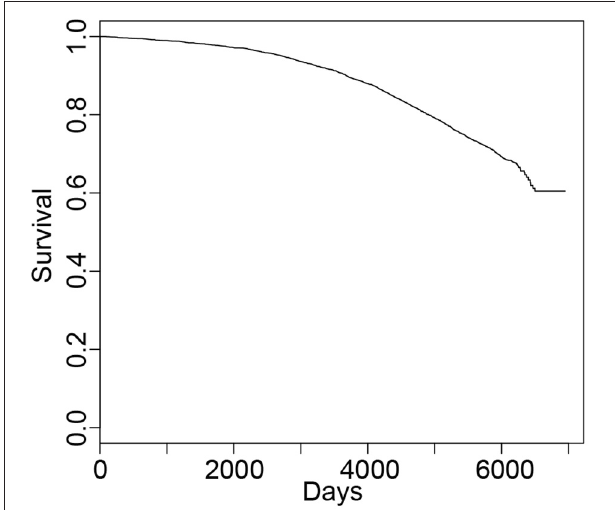
FIGURE 1 | Survival curve for all-cause mortality. The median time to death is 5,802 days from enrollment (average ± SD = 5,251 ± 1,207 days) with 1282 deaths ( N = 4,504 and 14 with missing data).